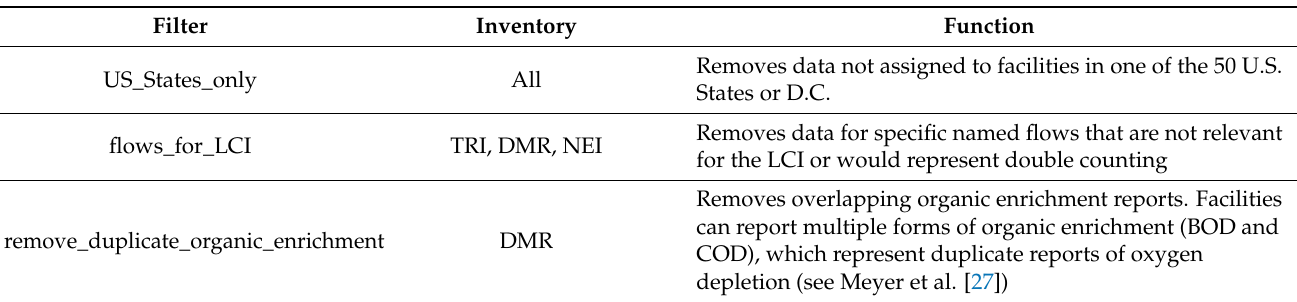
Table 3. Filters available for stewi